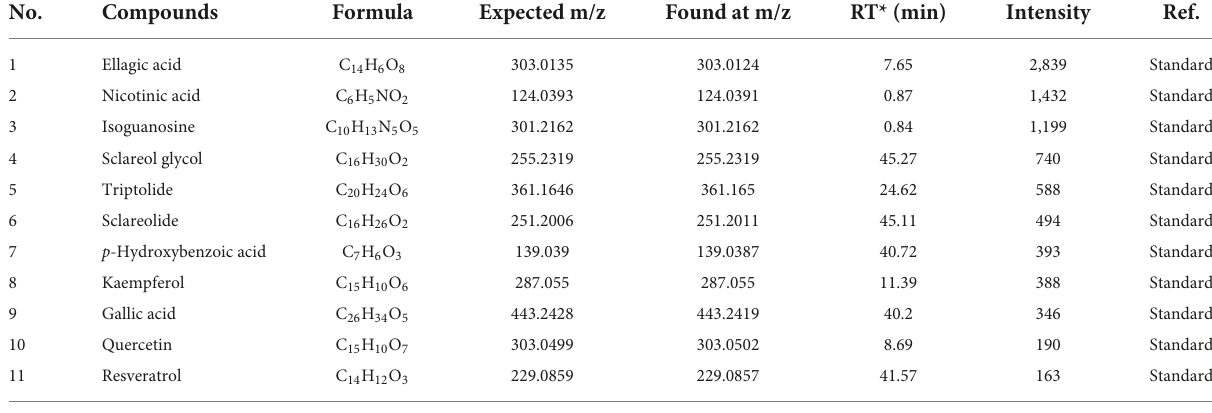
( Figure 2D ). All the straight lines of υ vs. [ α -glucosidase] passed